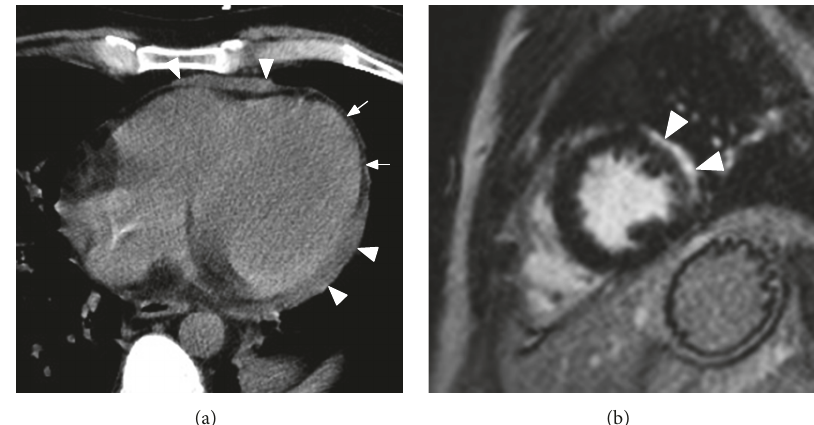
Figure 3: (a) Follow-up noncontrast CT after chemotherapy demonstrates marked treatment response with visualization of the pericardial fat (arrows) andmildresidualsofttissuealongtheanteriorRVandlateralLV (arrowheads) .(b)CMRDMEperformedforfurthercharacterization shows avid delayed enhancement of the soft tissue along the lateral LV (arrowheads) , compatible with posttreatment scar.